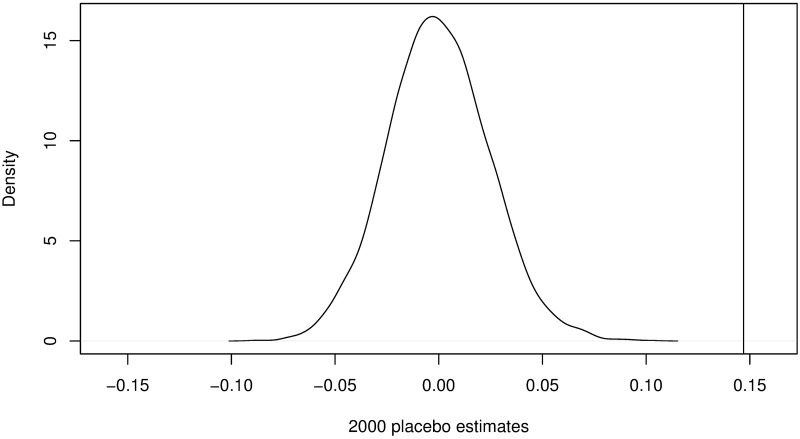
Density plot of the distribution of 2000 placebo estimates of the effect of OA on CiteScores.